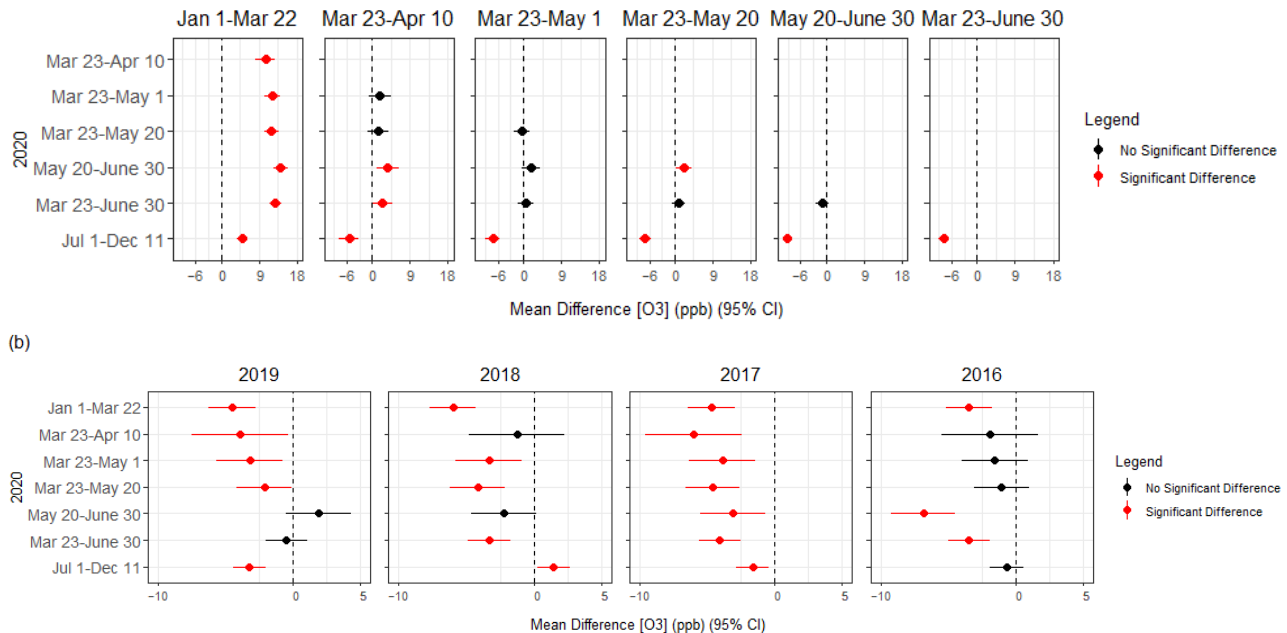
Figure 18. Post hoc test results for intra-annual and interannual hourly O 3 concentration comparisons at the Taft site: ( a ) intra-annual at Taft; ( b ) interannual at Taft. The circles represent the difference in mean hourly O 3 concentration between the two time periods on each axis along with the 95% confidence interval (e.g., top left of top figure: (mean O 3 23 March–10 April) − (mean O 3 1 January–22 March) = 10.56 ppb).